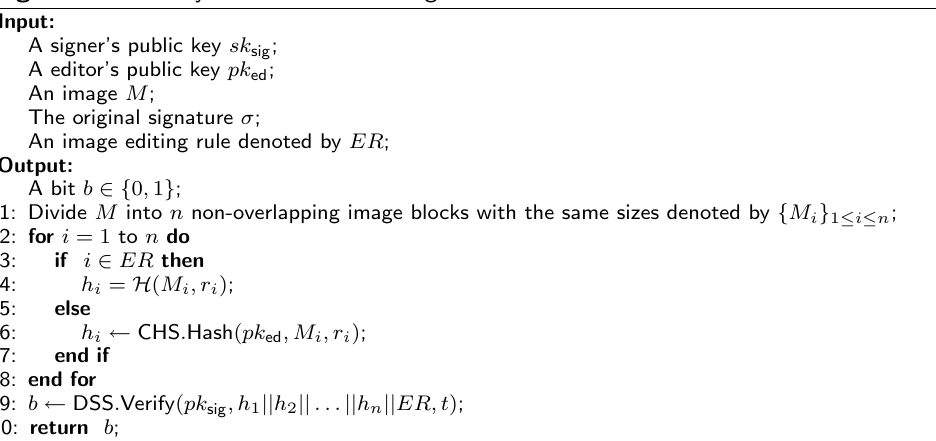
Algorithm 4 Verify: The verification